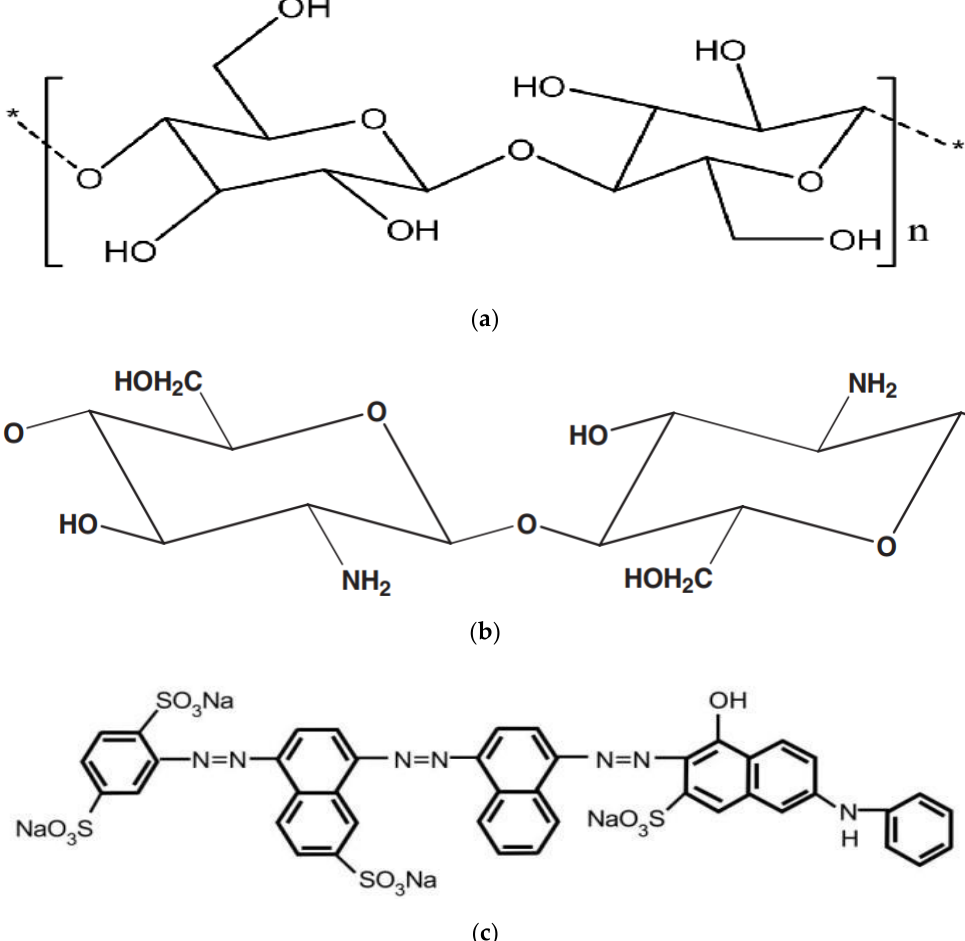
Figure 2. ( a ) Chemical structure of nanocellulose. ( b ) Chemical structure of chitosan. ( c ) Chemical structure of direct blue 78 dye.